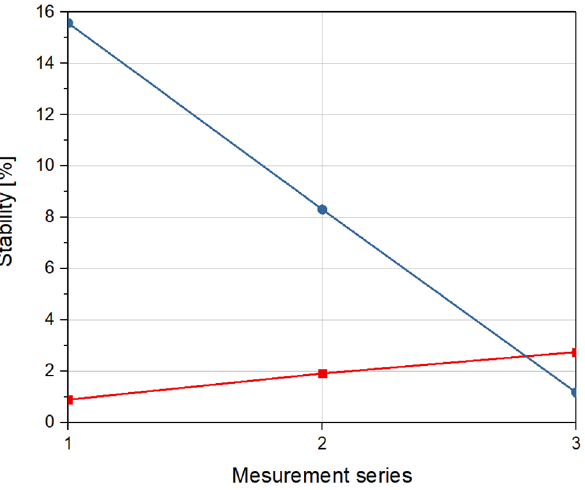
Figure 7. Stability of scattering coefficient for a sample with 2 mL of glycerol (red) and a sample with 5 mL of glycerol (blue) over time, in relation to reference measurement.